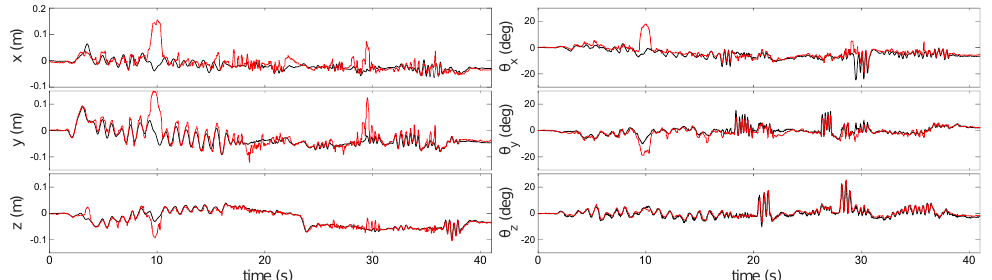
Figure 10. Comparison between pose estimates generated by ESPEE (red) and ground truth generated by the Vicon motion capture system (black). ESPEE still performs relatively well in a featureless scene consisting of only lines without